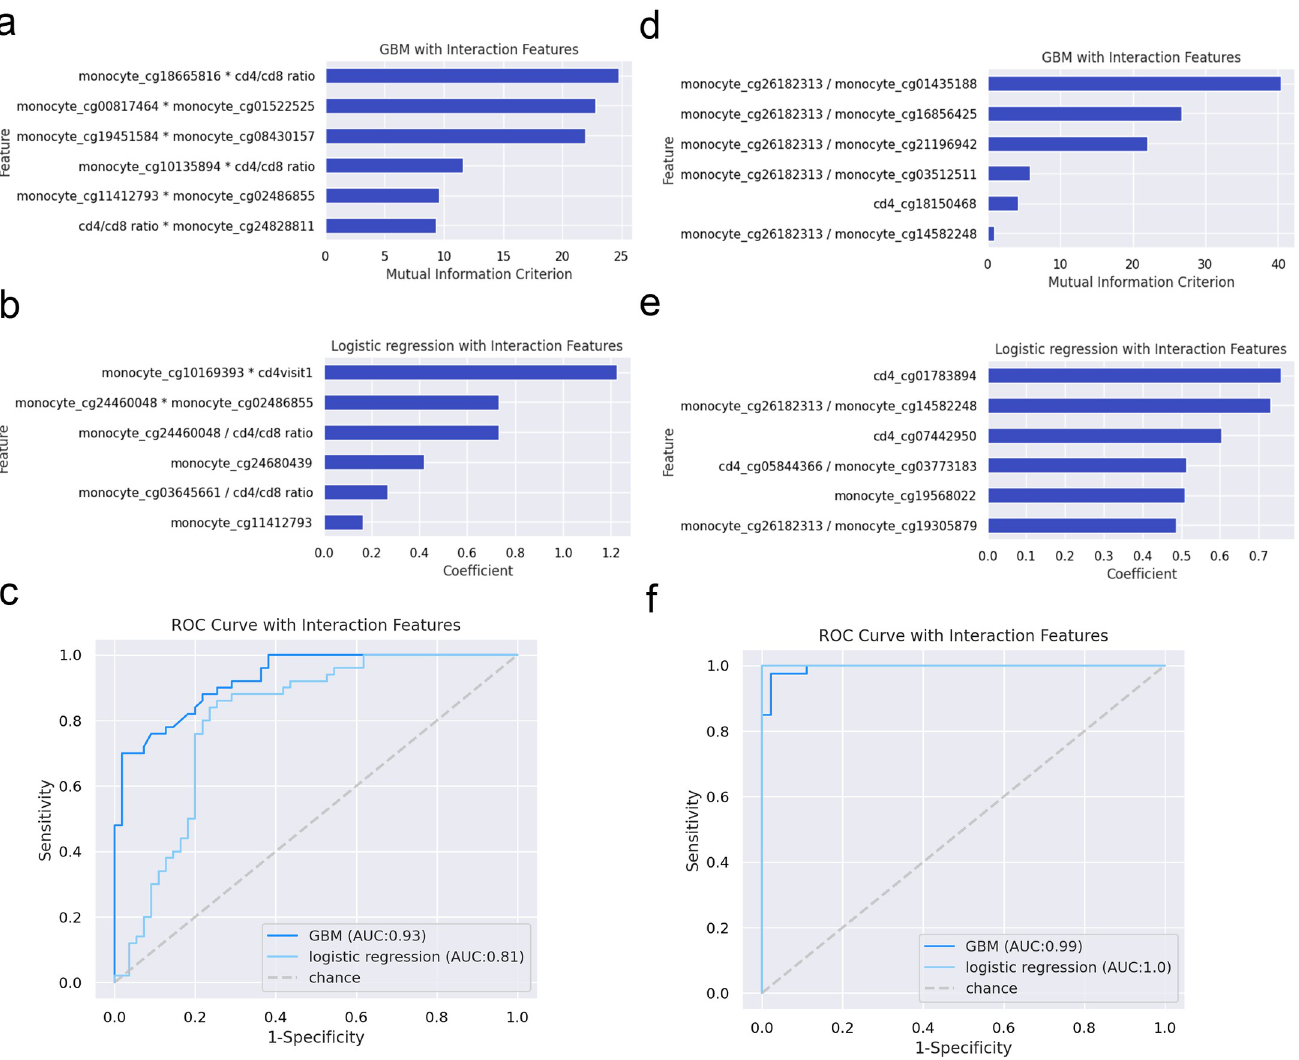
Fig 9. DNA methylation features associated with AHI in monocytes and CD4 + T lymphocytes predict favorable clinical phenotypes and neurocognitive performance following ART. (a-b) Feature importance plots of gradient boosting machine learning and logistic regression models with interaction features for predicting favorable clinical phenotype at week 96 post-ART utilizing cell-type specific DNA methylation measures and clinical parameters (estimated days of infection, viral load, CD4 count, CD8 count, and CD4/CD8 ratio) during viral establishment in AHI prior to ART initiation. (c) Receiver operating characteristic curve showing performance of classification models (area under curve AUC) in discovery AHI DNA methylation feature set. (e-f) Feature importance plots of gradient boosting machine learning and logistic regression models with interaction features for predicting neurocognitive performance trajectory at week 96 post- ART. (g) Receiver operating characteristic curve showing performance of classification